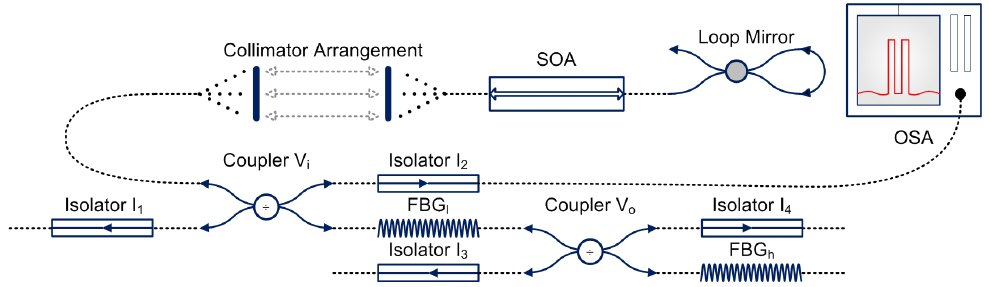
Figure 1. Design of the laser based two mode experimental scheme